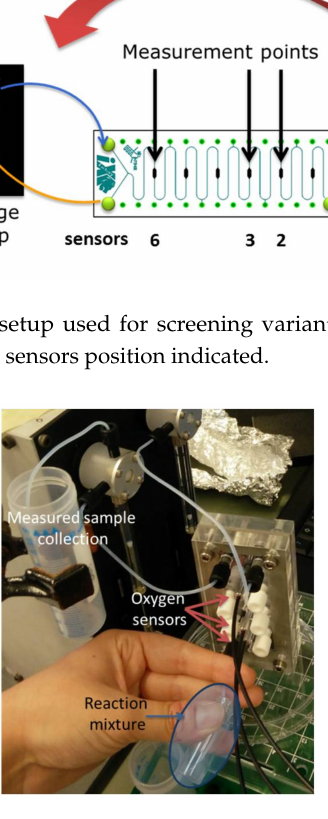
Figure 5. Picture of the pulling sample setup with the meander microchannel in the vertical